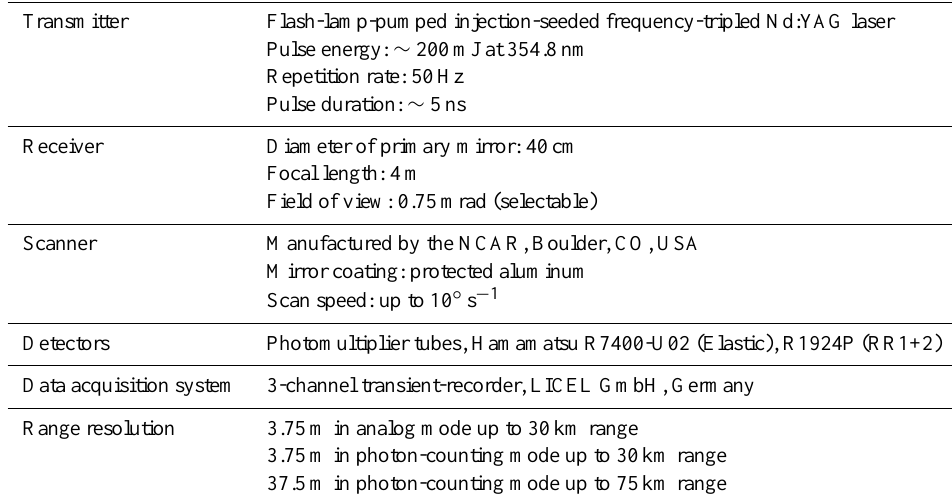
Table 1. Overview of key parameters of the rotational Raman lidar of University of Hohenheim (UHOH RRL) during the measurements discussed